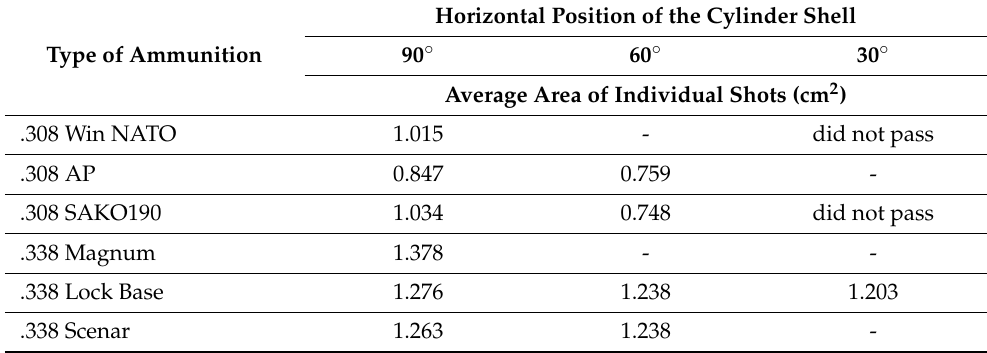
Table 1. Average areas of individual shots.